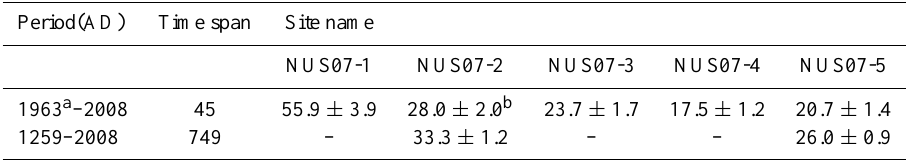
Table 3c. Annual accumulation rates at several sites of the Norwegian-USA (NUS) traverse (Ansch¨utz et al., 2011) in the vicinity of the JASE traverse.